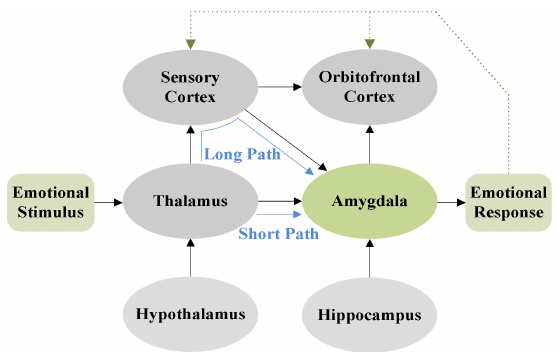
Figure 1. Schematic diagram of the amygdala interaction with other brain systems in the limbic